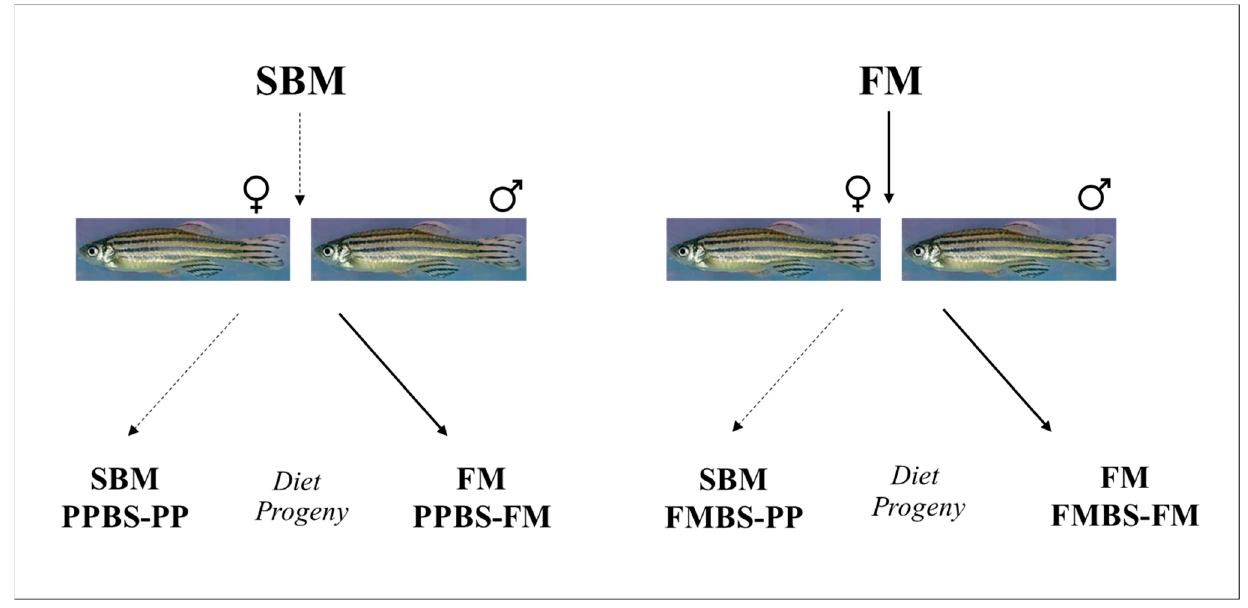
Figure 1. The experimental design of the study. Broodstock fish were fed soybean meal (SBM) or fishmeal (FM)-based diets for two weeks and the offspring from each group was then challenged with SBM diet.